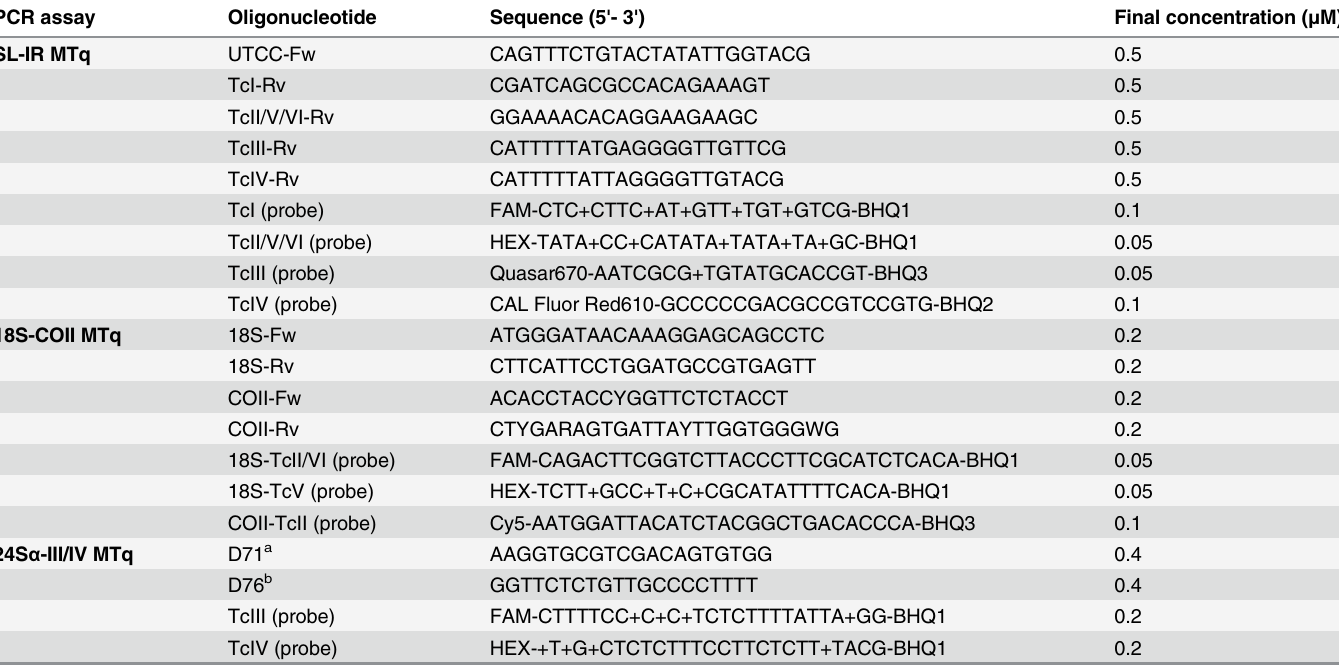
Table 2. Sequences and concentrations of primers and probes used in the multiplex real-time PCR